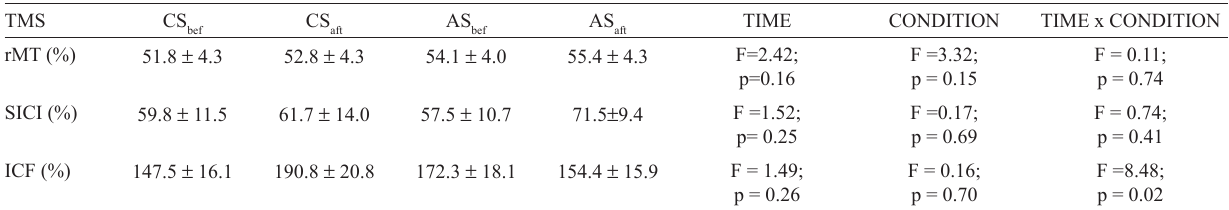
Table 2 - Transcranial magnetic stimulation (TMS) results. CS tion; AS = before active stimulation; AS bef